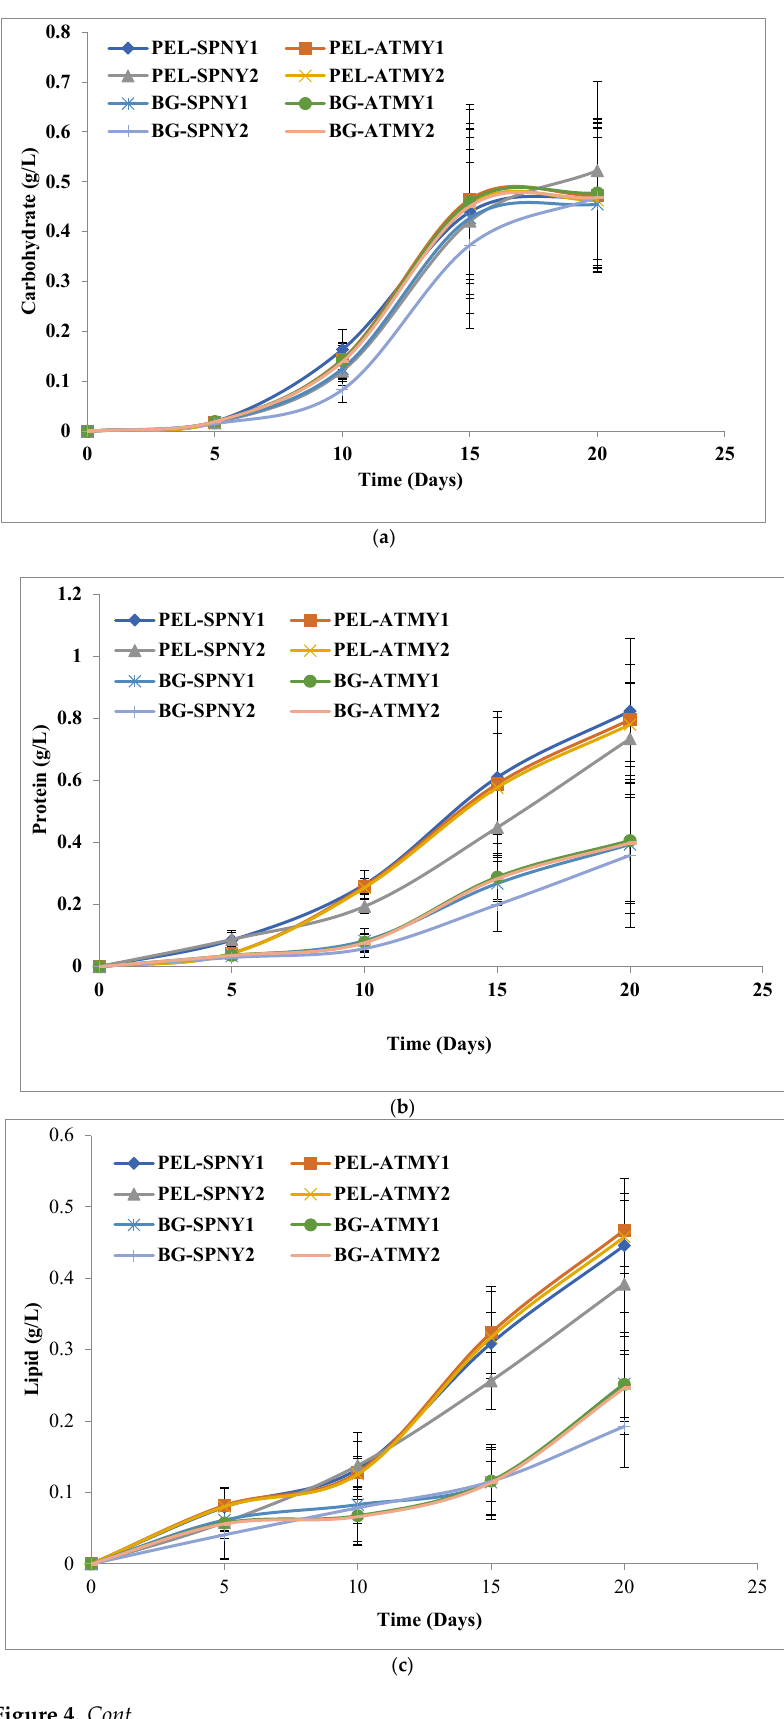
Figure 3. Growth of C. pyrenoidosa at solar inclination angles of 32.9°.